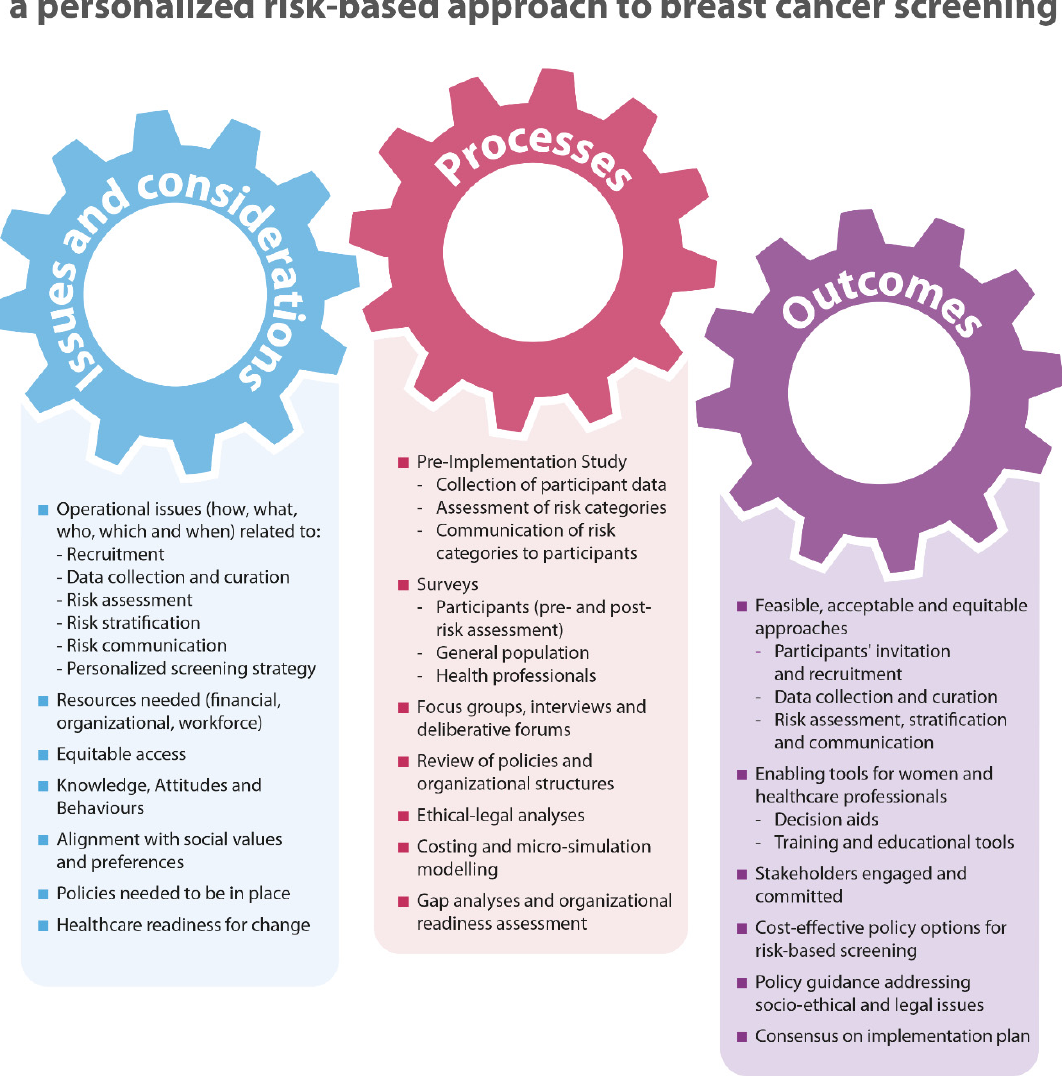
Figure 2. Framework to support implementation of a personalized risk-based approach to breast cancer screening.